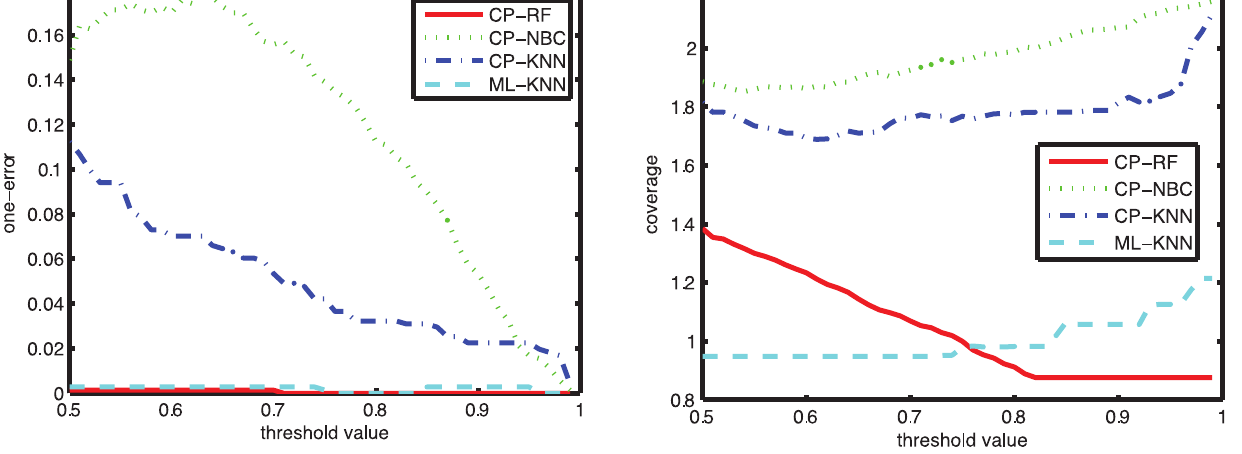
Figure 6. Comparison of coverage with different thresholds.